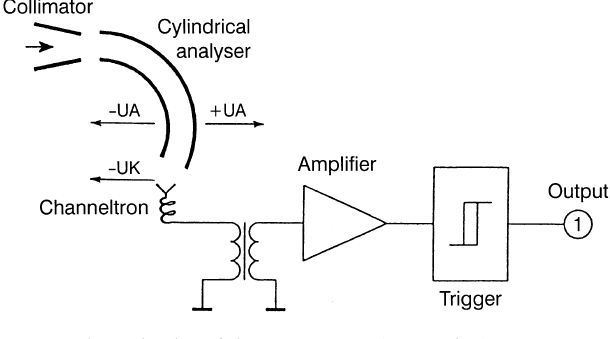
Fig. 4. Schematic plot of the MPS sensor (one section)